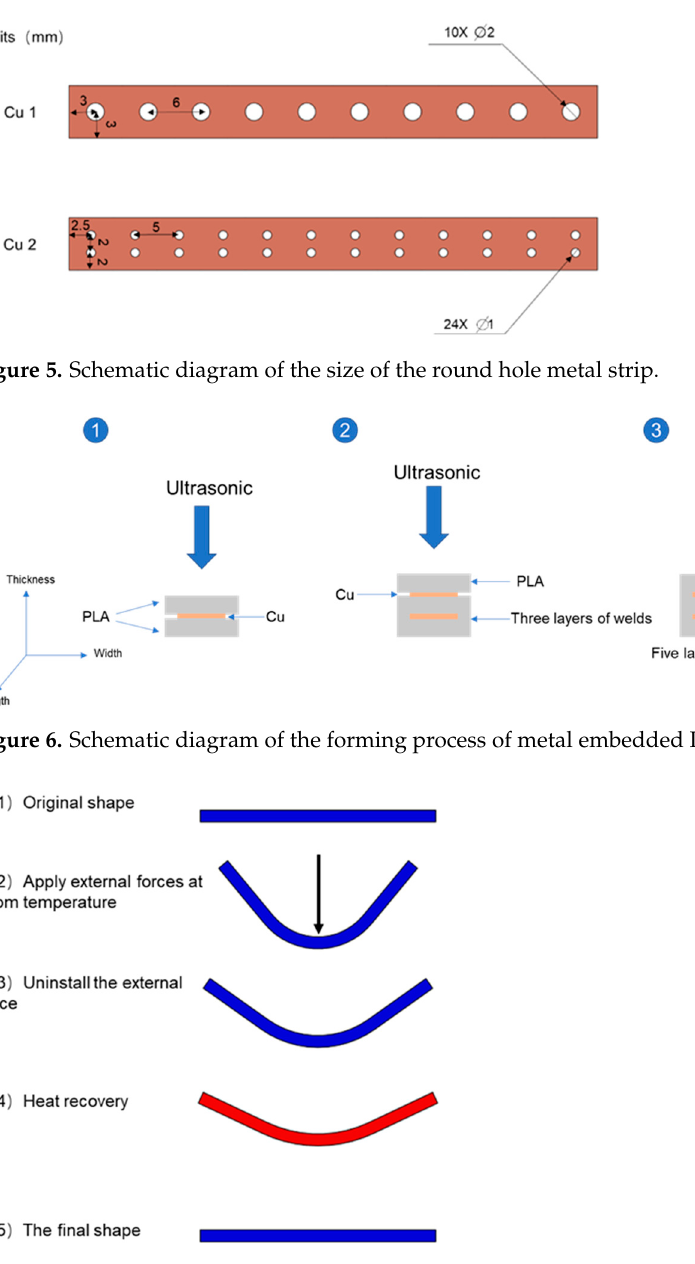
Figure 7. The deformation recovery process of the sample .